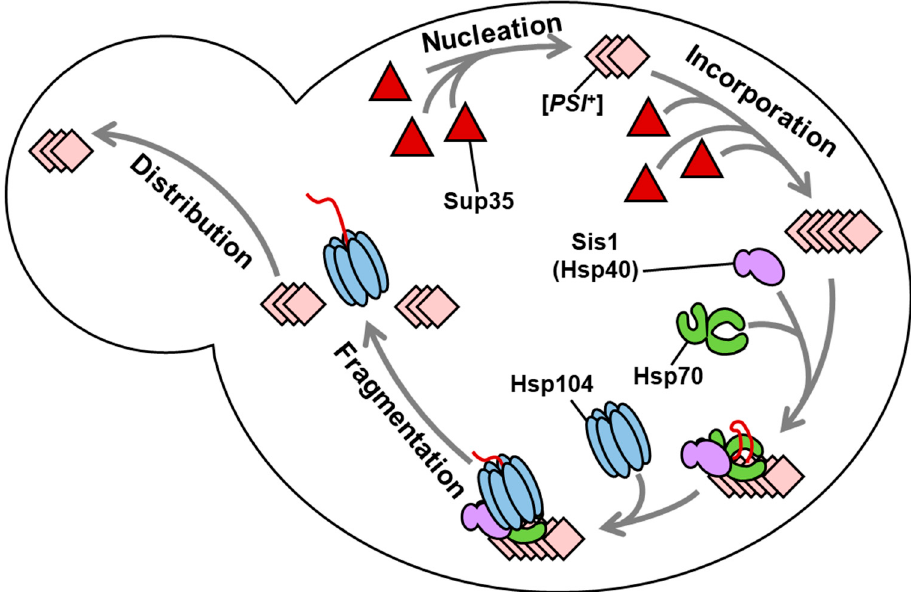
Figure 1. Current model of chaperone-dependent prion propagation in vivo . Four interdependent processes are necessary for prion formation and propagation in yeast. Prions arise from a rare event in which protein monomers (represented as triangles in the case of the prion-forming protein Sup35 above) misfold and form a thermodynamically-stable, ordered aggregate (“nucleation”). Aggregates increase in size by recruiting more soluble monomer (“incorporation”). To be transmissible, however, the fibril must also be a target for the chaperone machinery [2]. Hsp40-class chaperones, particularly Sis1, and the Hsp70 Ssa, are thought to functionally recruit the disaggregase Hsp104, responsible for the physical fragmentation of amyloid fibrils to create new propagons (“fragmentation”) that may be inherited by daughter cells (“distribution”).